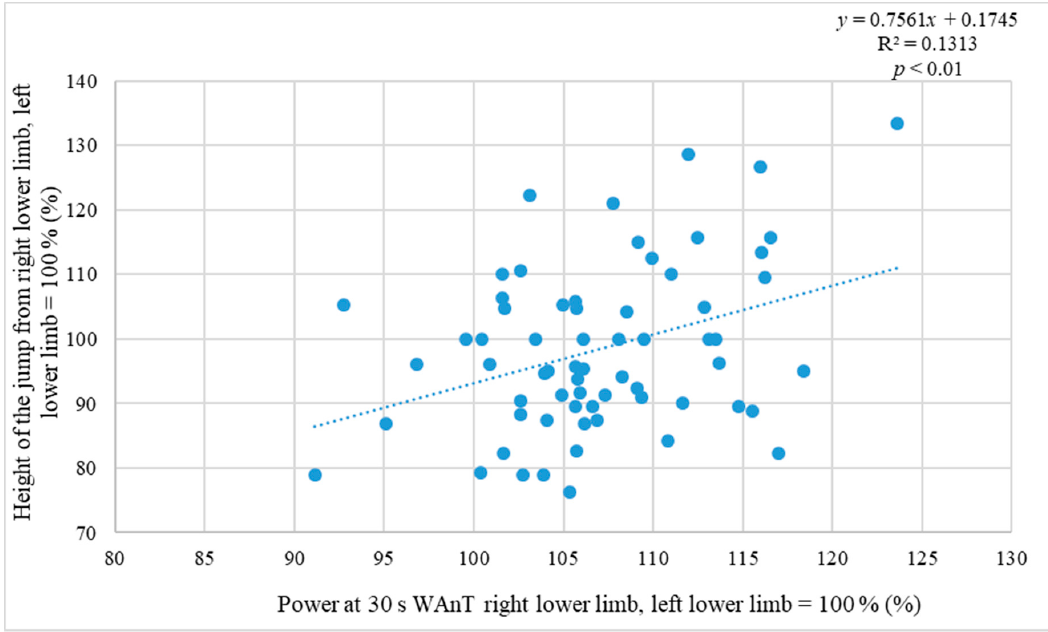
Figure 3. Relation of power at 30 s Wingate anaerobic test (WAnT) and jump height.